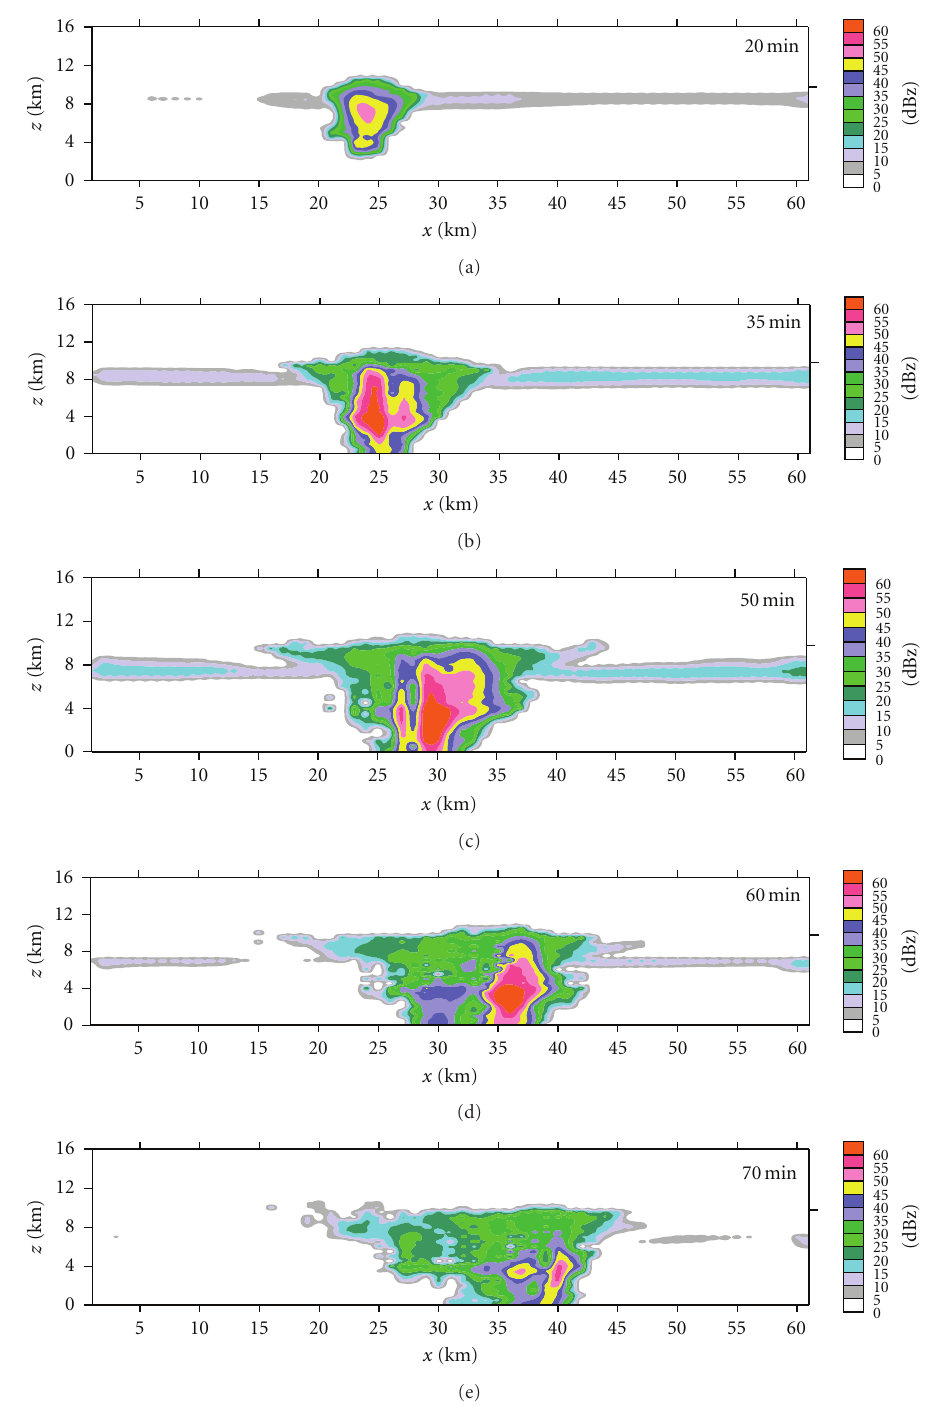
Figure 5: Radar reflectivity (dBz) along the SW-NE vertical cross-section. Model results at 25, 35, 50, 60, and 70 minutes of the simulation time. Model run